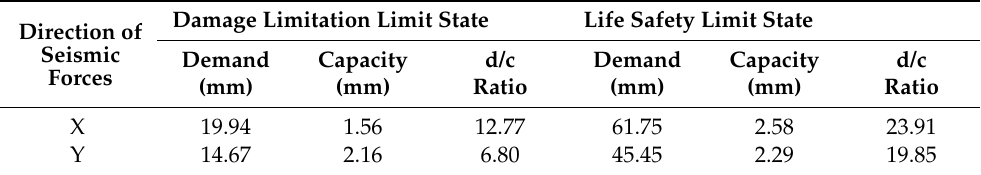
Table 6. Seismic capacity and seismic demand displacements for the model of the central wing. Direction of